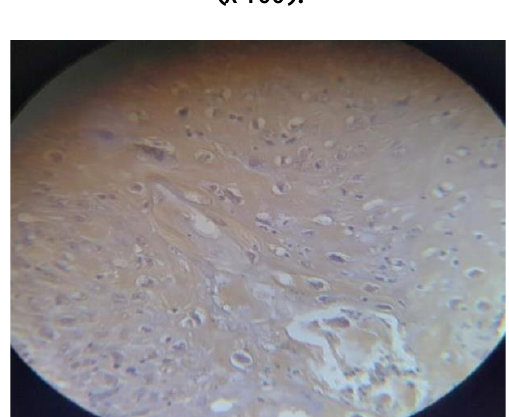
Figure 2: Faint staining (score1 in SIS) of Ang-2 expression in the studied samples (X100).